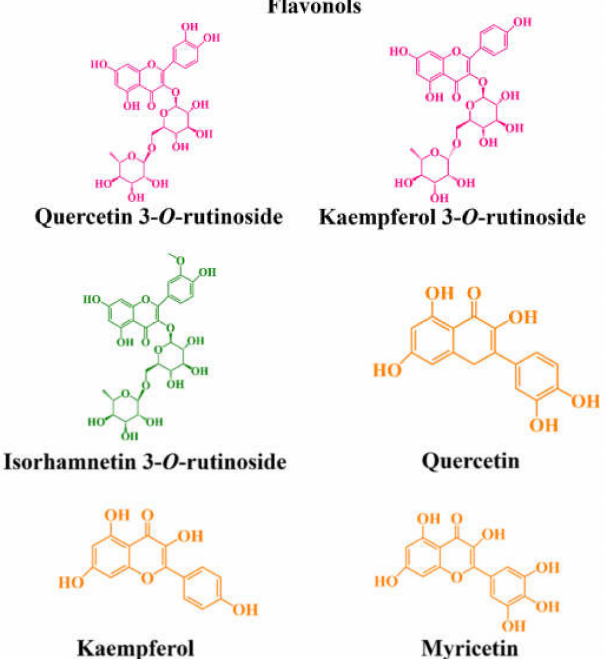
Figure 3. Main flavonols reported in sweet cherries (pink color) and both tart and sweet cherries (green color), and both highbush and rabbiteye blueberries (orange color). (Figure created with ChemDraw Professional 16.0 (CambridgeSoft, Perkin Elmer Inc., Waltham, MA, USA)). Focusing on flavan-3-ols (Figure 4A), tart cherry contains ( − )-epicatechin (0.0–28.22 mg per 100 g fw), procyanidin B1 (0.0–27.69 mg per 100 g fw), and procyanidin C1 (0.0–8.60 mg per 100 g fw) in their constitution [74]. ( − )-Epicatechin is also one of the most predominant flavan-3-ols reported in sweet cherries (0.23–397.19 mg per 100 g fw), followed by (+)- catechin (0.13–84.34 mg per 100 g fw) and procyanidin dimer type 2 (1.59–26.47 mg per 100 g fw) [40,57,76,77,96]. Relative to blueberries, considerable amounts of (+)-catechin and ( − )-epicatechin were detected in both highbush and rabbiteye blueberries [60,64,94].